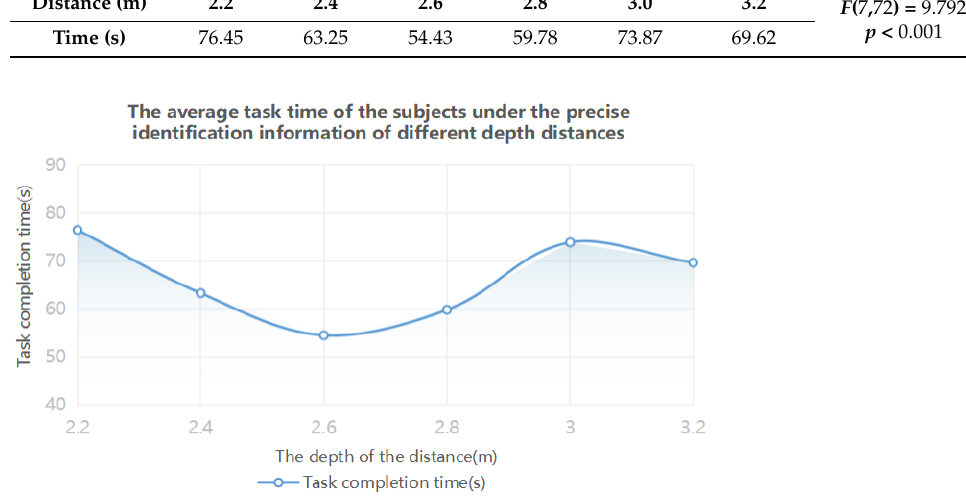
Table 6. Time data after the depth distance range of the accurate identification information is di- vided.